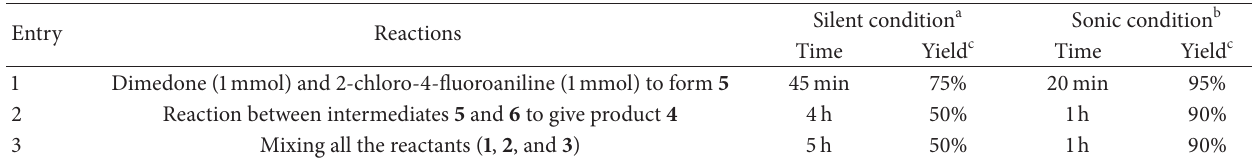
Scheme 3: Formation of 𝛽 -enaminones. Table 1: Comparison between CAN catalysed silent and sonic